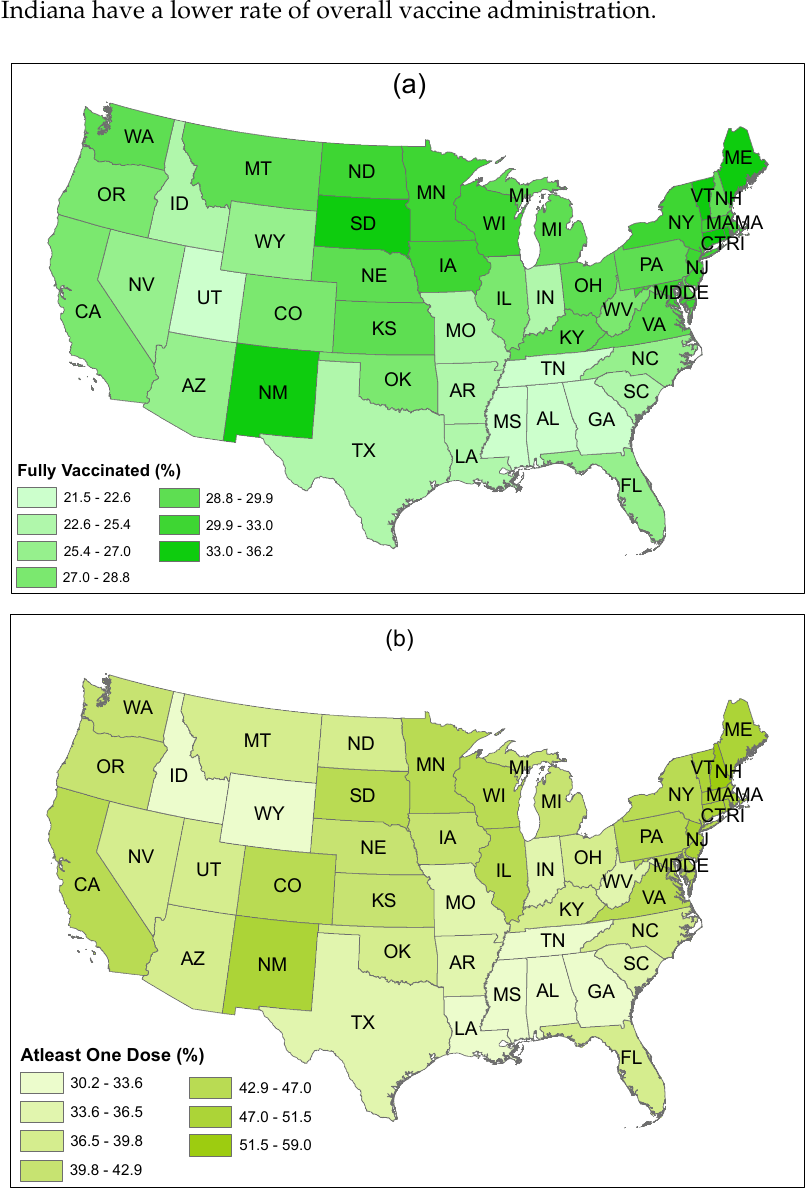
Figure 13. ( a ) Fully vaccinated people per 100 persons; ( b ) People with at least one dose of vaccine per 100 persons (Data source: